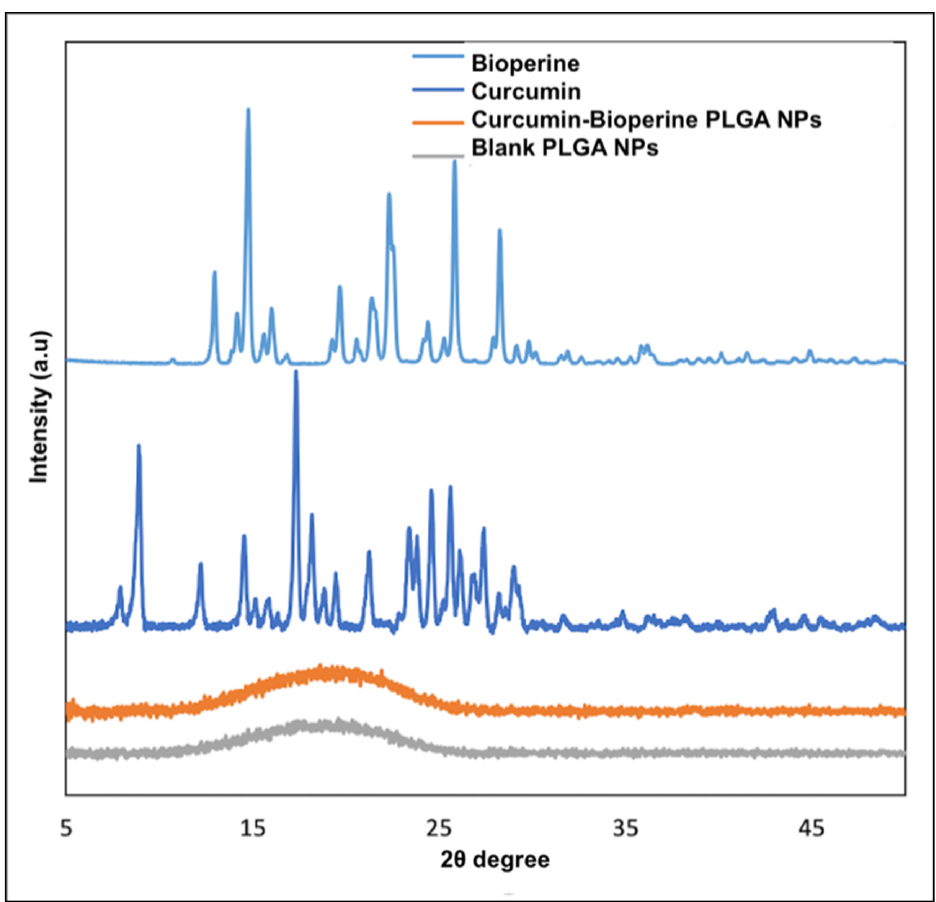
Figure 1. ( A , B ) SEM image of curcumin-Bioperine PLGA NPs 1:0.2:10 and 1:1:10 (at scale 5.00 μ m). ( C , D ) Size distribution